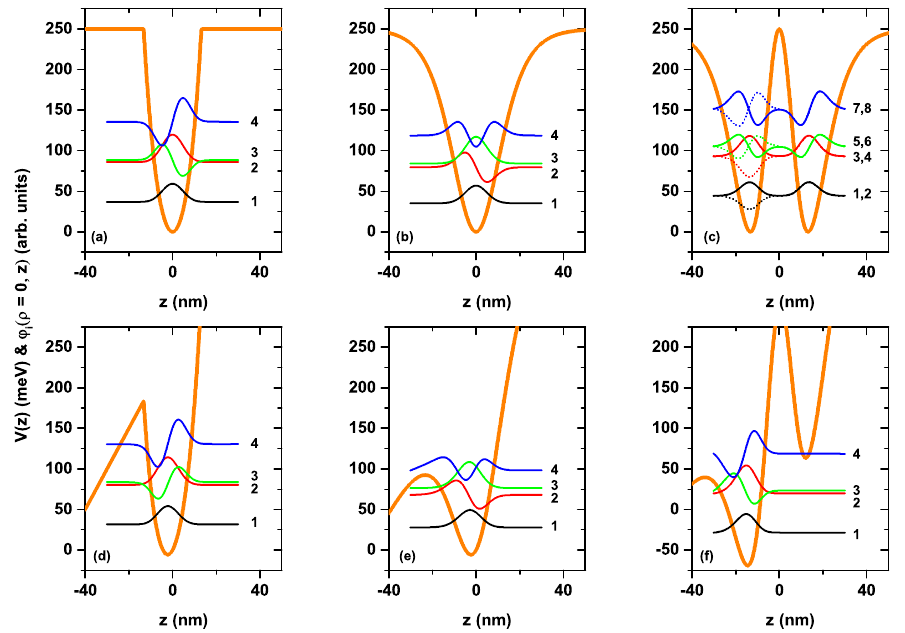
Figure 3. The z -dependent axial finite confinement potential ( V n ( z ) ) and the wave functions along the z -axis of first four bound-states ( ϕ i ( ρ = 0, z ) ) for a confined electron in a CQD with k = R = 15nm. Results are for zero ( a – c ) and 50kV/cm ( d – f ) applied electric field, with l = 0. Calculations are reported for the three considered axial finite confinement potentials: V 2 ( z ) ( a , d ), V 3 ( z ) ( b , e ) and V 4 ( z ) ( c , f ). Each wave function is vertically shifted such that its position on the energy scale is given by its corresponding eigenvalue. In panel ( c ), there are four pairs of doubly degenerate states, one with even symmetry (solid line) and the other with odd symmetry (dotted line) with respect to the point z = 0. The labels in each figure indicate the states in order of increasing